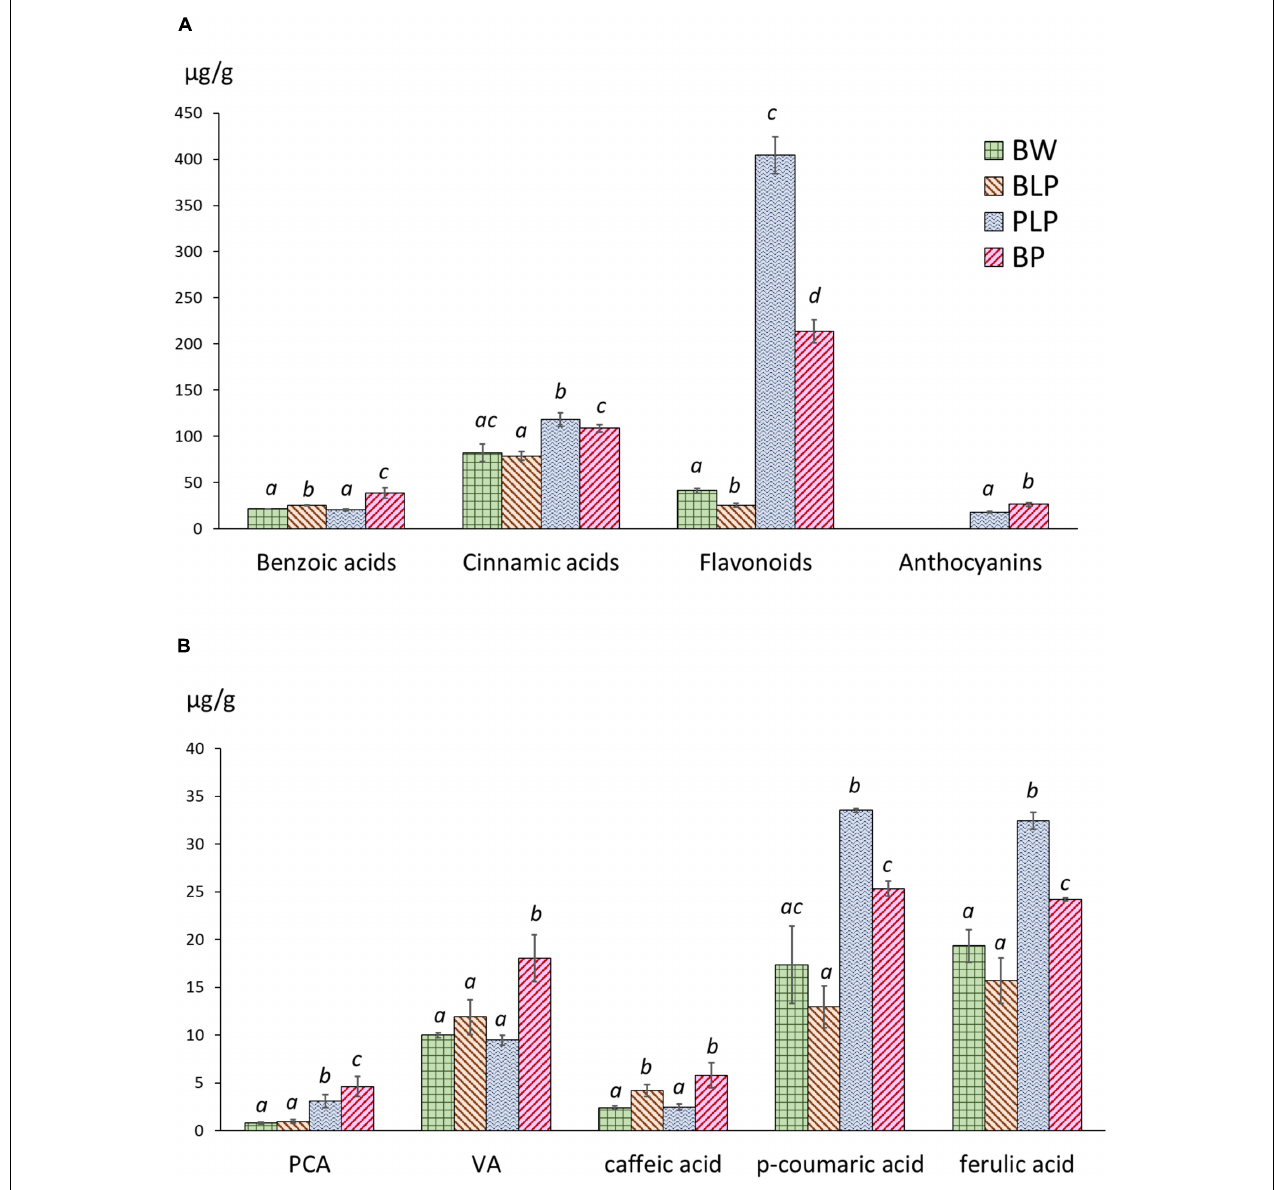
FIGURE 7 | (A) The total contents of benzoic acids, hydroxycinnamic acids, flavonoids, and anthocyanins in NILs at the early dough stage (stage 3) of spike maturity. (B) Concentrations of individual phenylpropanoids at stage 3. PCA, protocatechuic acid; VA, vanillic acid. The different letters denote statistically significant differences between the lines ( t test, p ≤